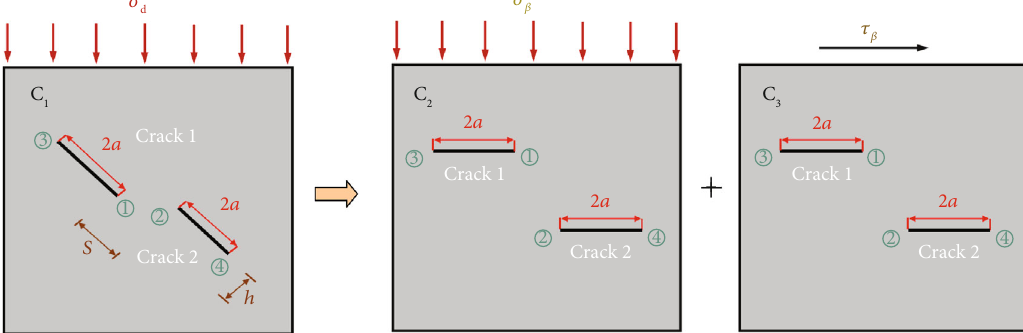
Figure 6: Superposition sketch of stress State C